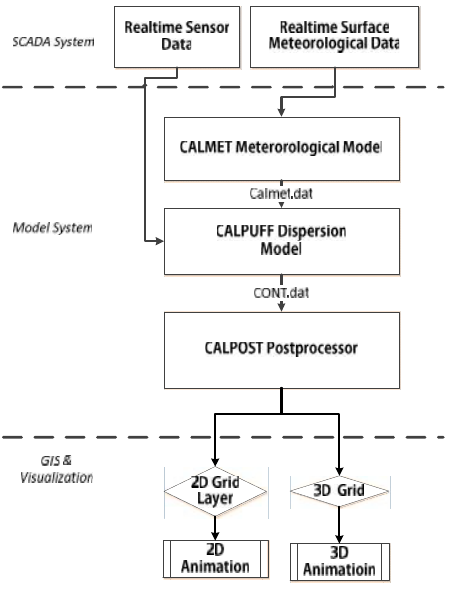
Figure 3. Schematic diagram of the main components and the data flow used in calculating gas dispersion model